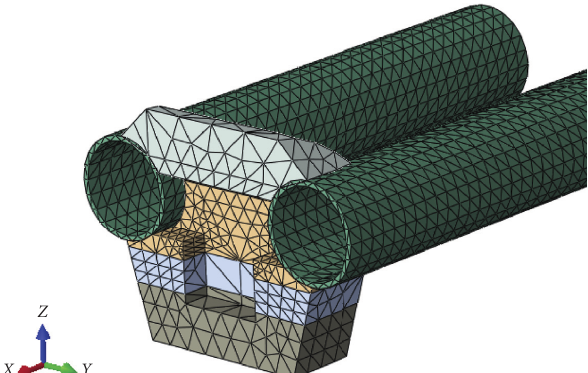
Figure 5: The cross passage and tunnel after the frozen soil wall